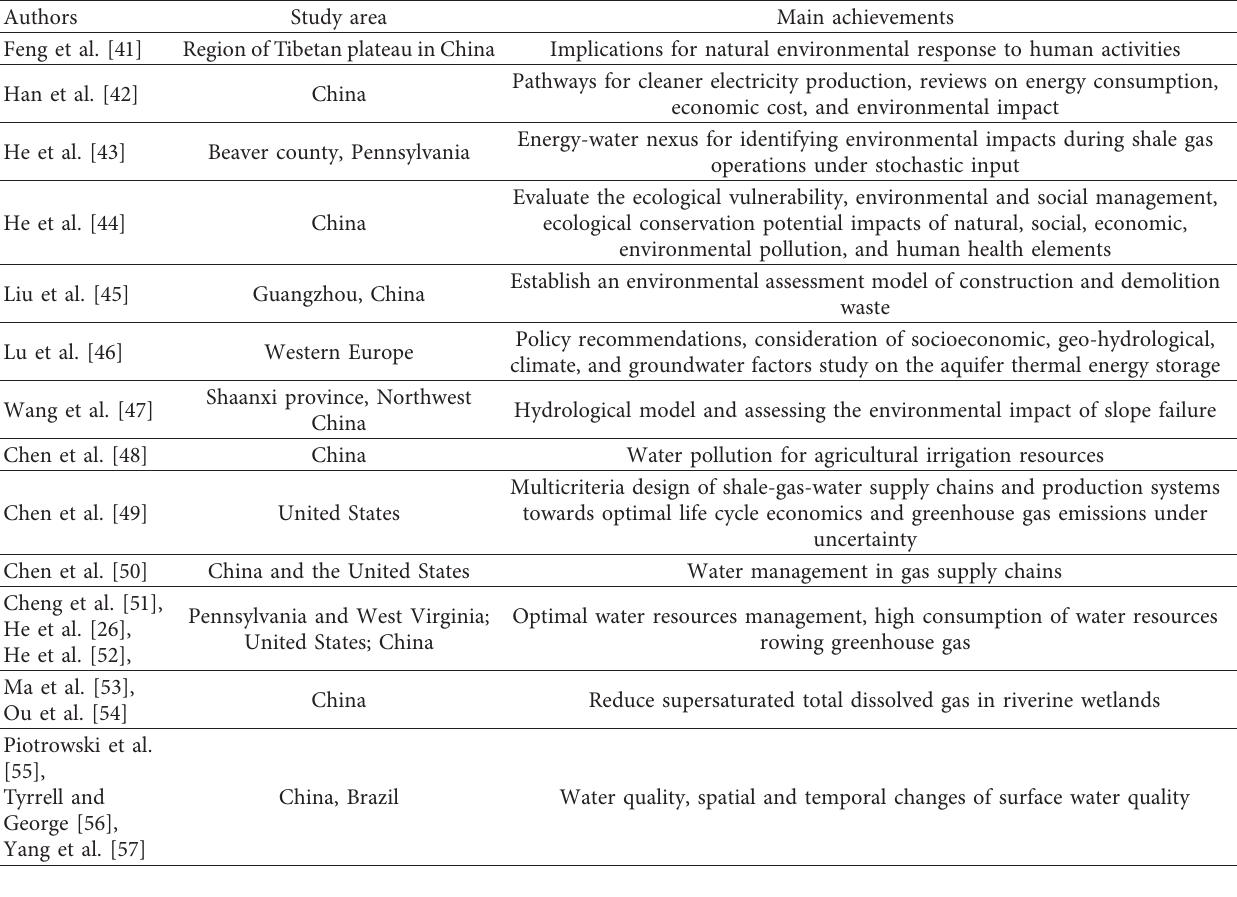
Table 1: Some recent geo-hydro-environmental-based studies and their main achievements.